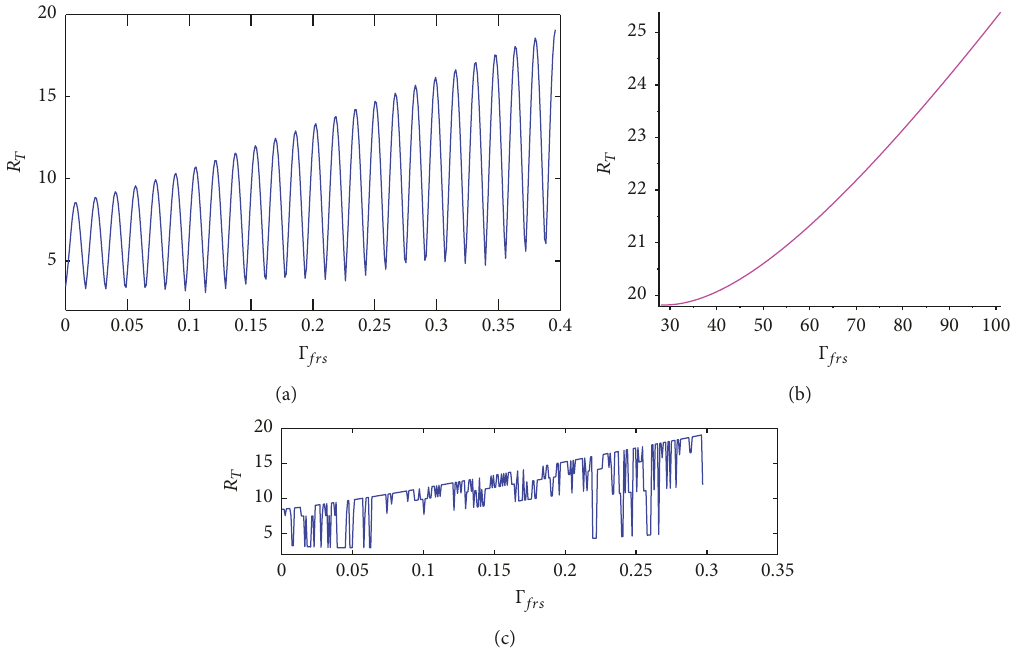
Figure 6: The effect of infection from 𝐼 𝐹 to rodents with septicemic plague on the periodic reproduction number.